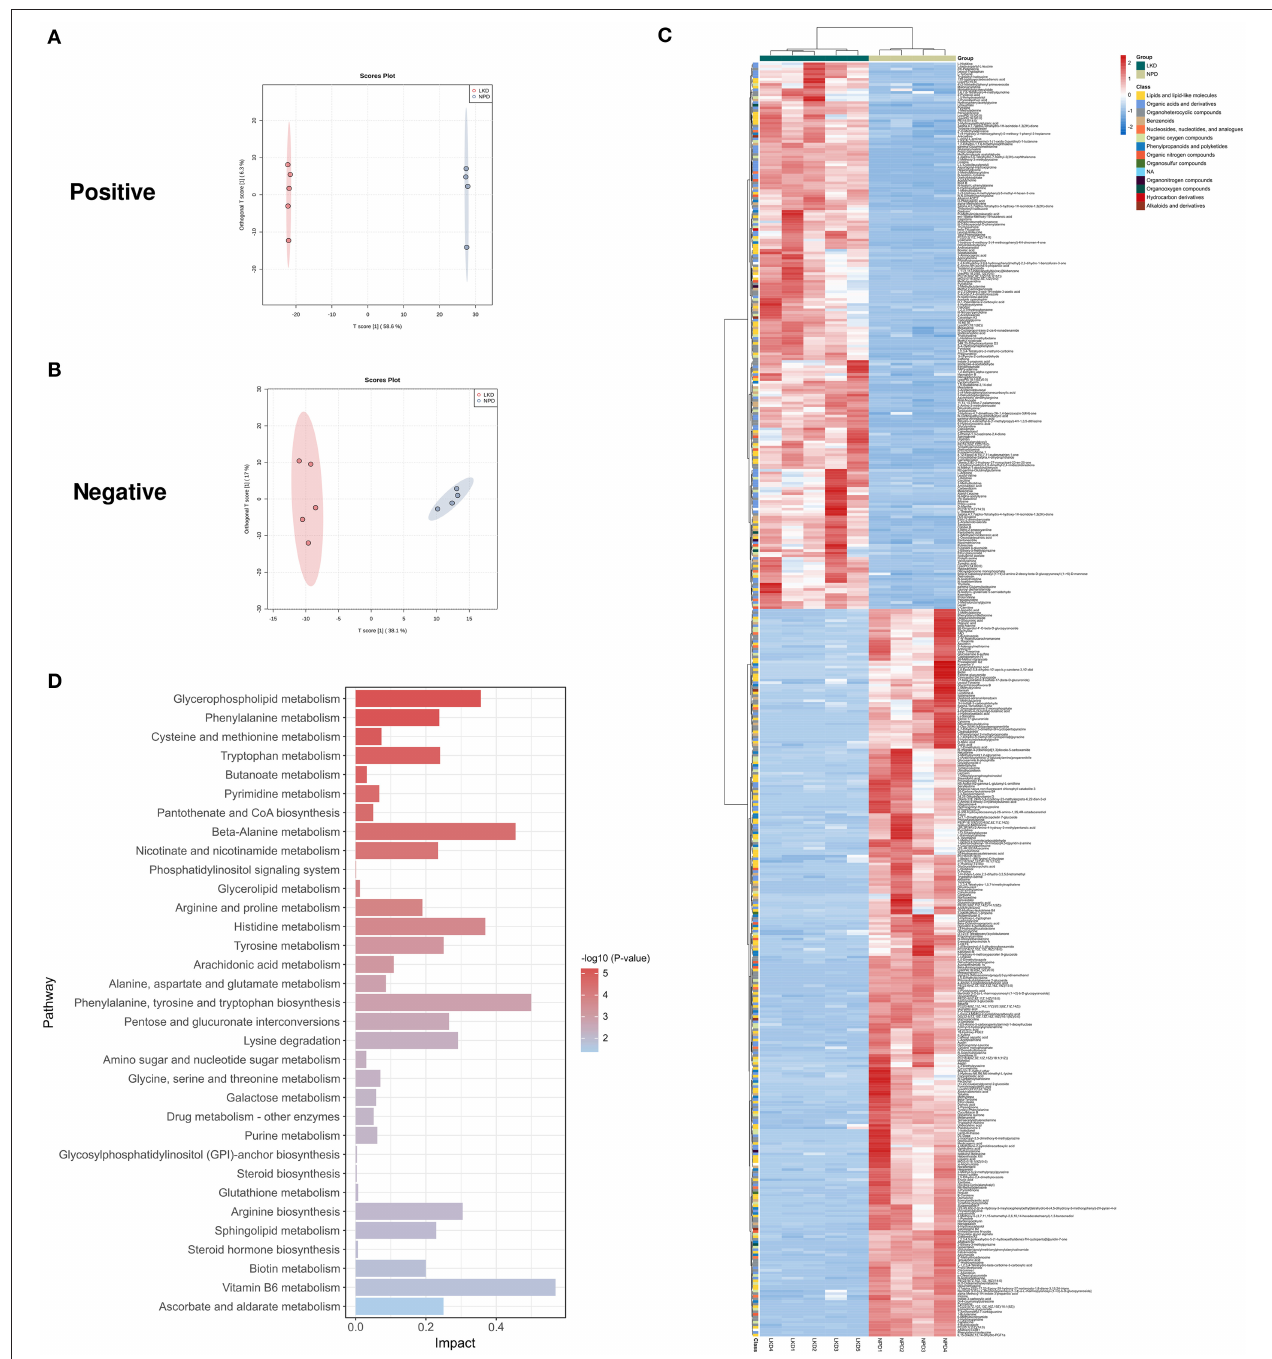
FIGURE 5 | Different expressed metabolites between LKD and NPD. (A) OPLS-DA score chart of positive mode between LKD and NPD. (B) OPLS-DA score chart of negative mode between LKD and NPD. (C) Heatmap of 492 DEMs between LKD and NPD after combing positive and negative modes. The classification of these DEMs is indicated by different colors. (D) Enriched KEGG pathways of DEMs between LKD and NPD with p < 0.05.